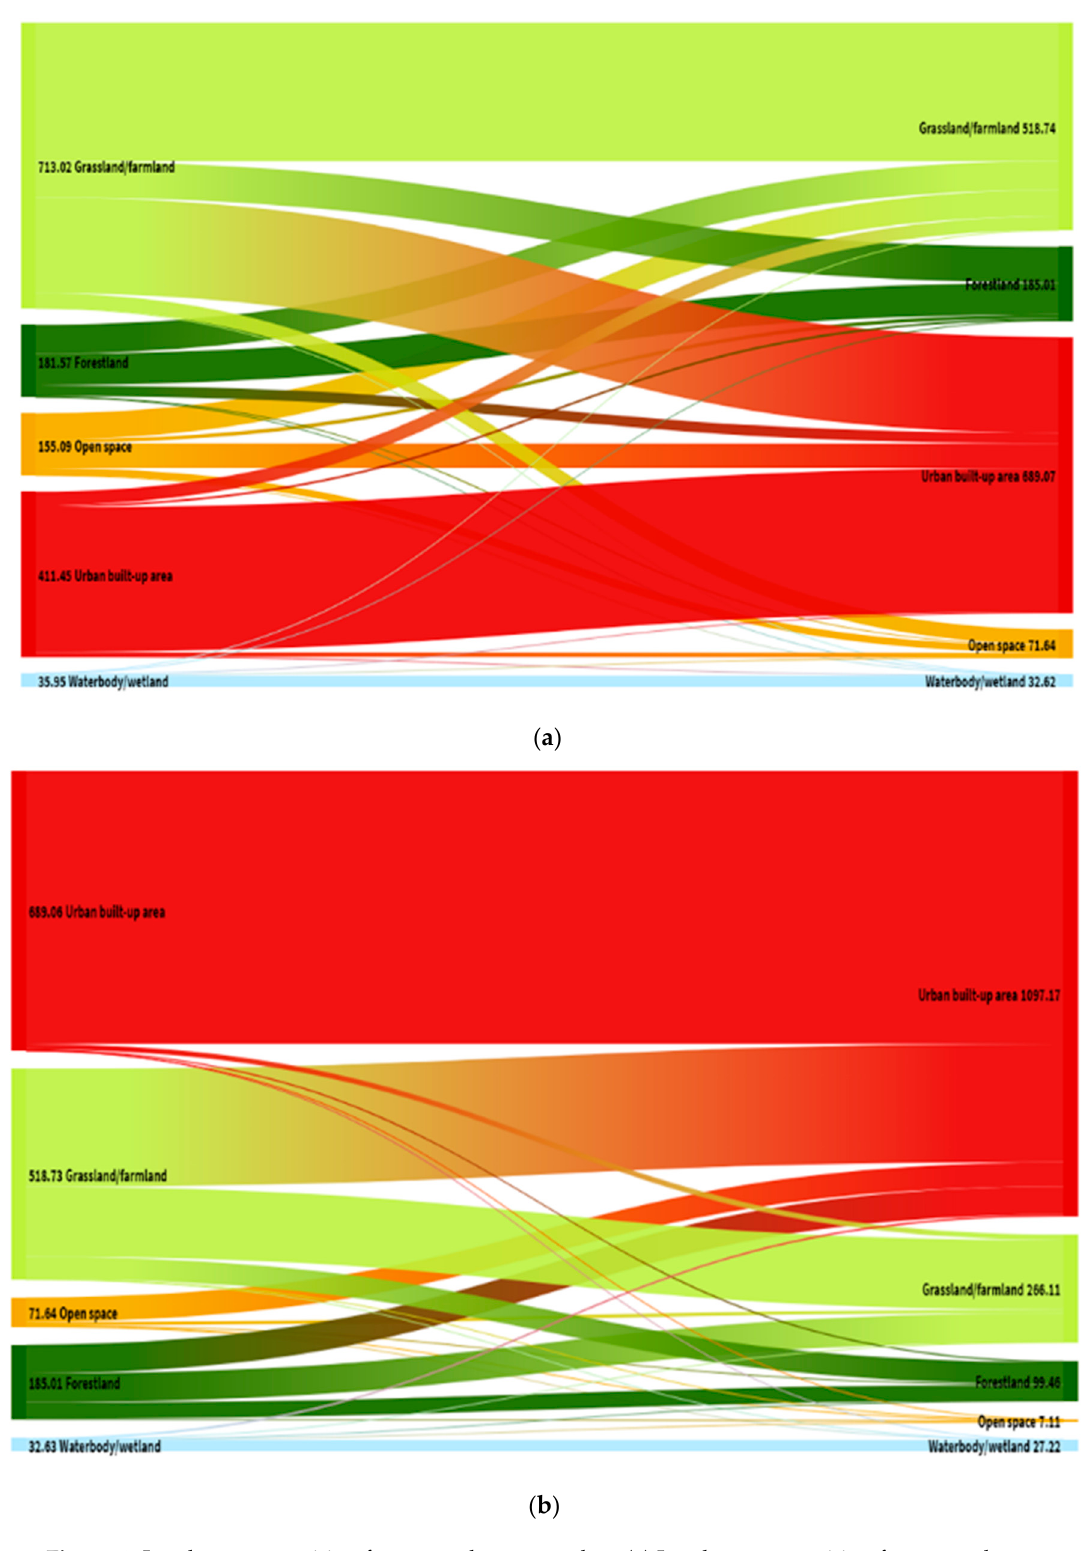
Figure 4. Land-cover transition from one class to another. ( a ) Land-cover transition from one class to another (2008–2017) [20]. ( b ) Land-cover transition from one class to another